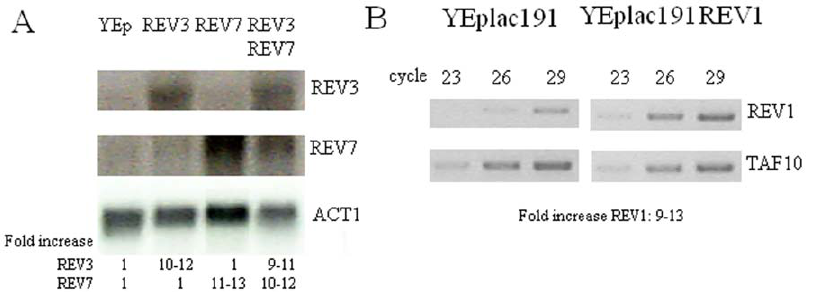
Figure 3. mRNA levels in overexpressing strains. A. Northern blot mRNA expression of REV3 and REV7 in strains transformed with YEplac195 empty plasmid (1 st lane), YEplac195- REV3 (2 nd lane), YEplac195- REV7 (3 rd lane) and YEplac195- REV3/REV7 (4 th lane). Numbers indicate the fold increase of REV3 and REV7 levels in overexpressing strains. mRNA of the ACT1 gene was used as a control. B. RT-PCR on REV1 in strains transformed with YEplac81- REV1 and YEplac181 empty plasmid. cDNA of the TAF10 gene was used as control. Numbers over the gel indicate the number of PCR cycles, number under the gel indicate the fold increase of REV1 levels in overexpressing strains.